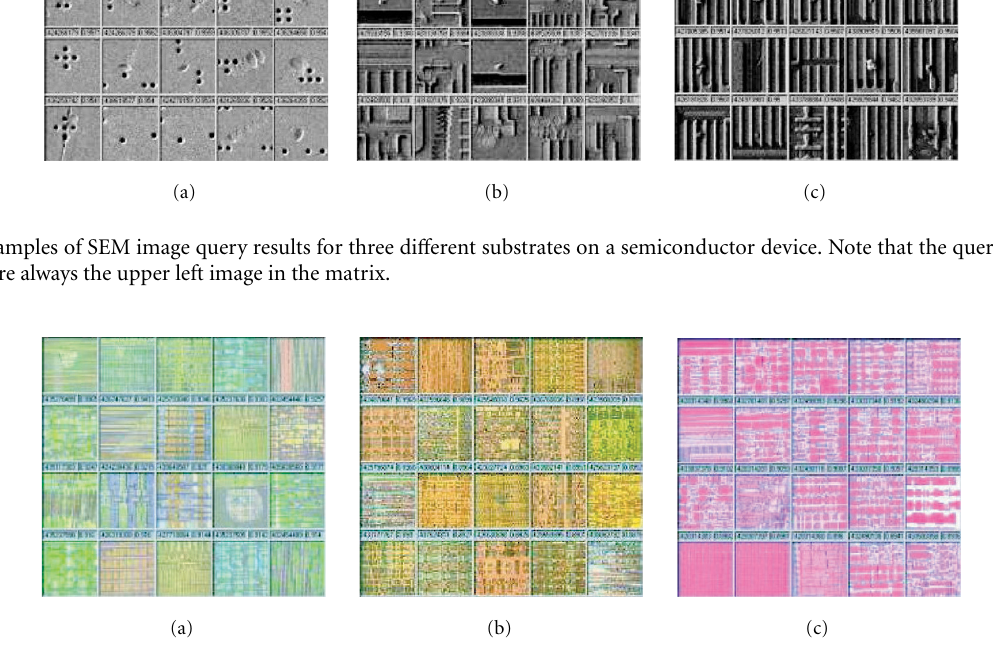
Figure 9: Examples of optical image query results for three di ff erent substrates on a semiconductor device. Note that the query image in (a), (b), and (c) are always the upper left image in the